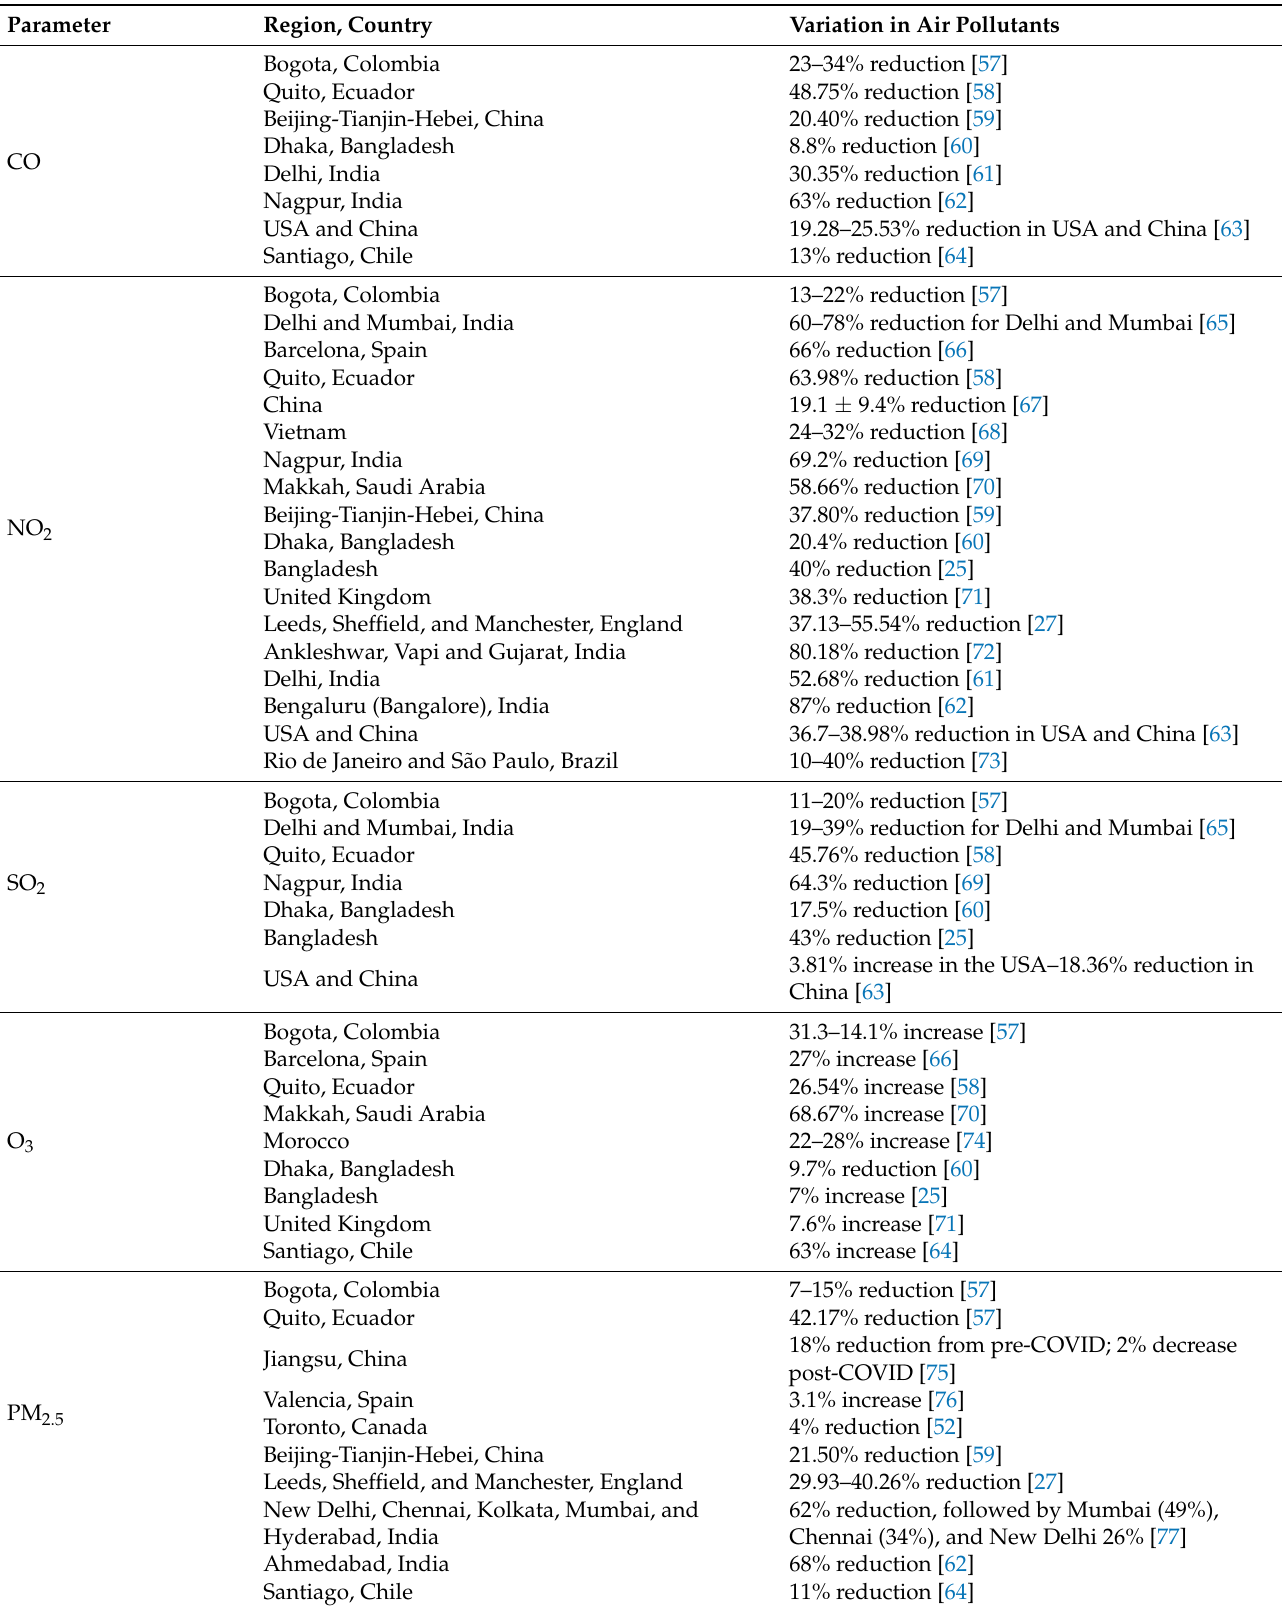
Table 1. Studies concerning the effects of lockdown measures to cope with the COVID-19 pandemic on levels of different air